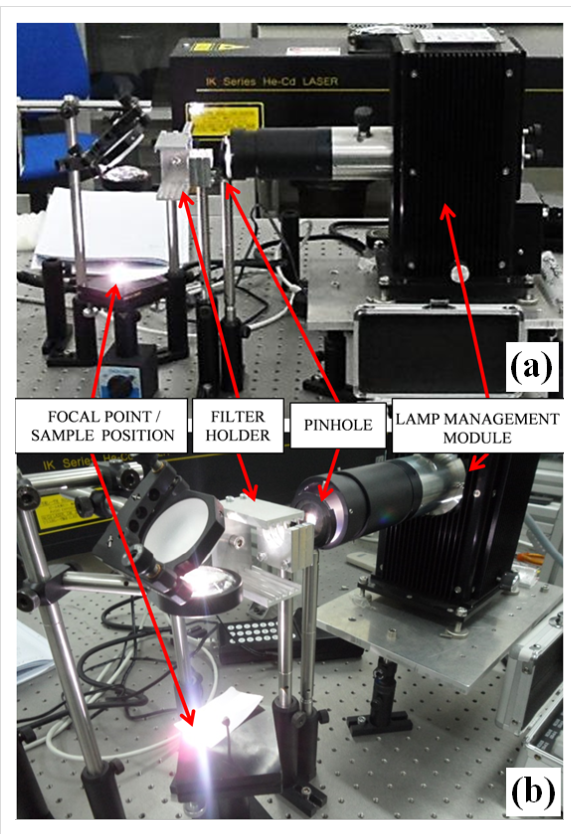
Figure 8: Images of the experimental setup for photo-ignition tests: lateral view (a) and front view (b).